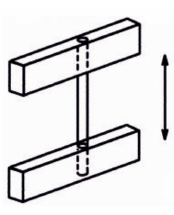
Figure 1. Illustration of the “H” type specimen. A silver wire fixed in two rubber plates during their crosslinking.